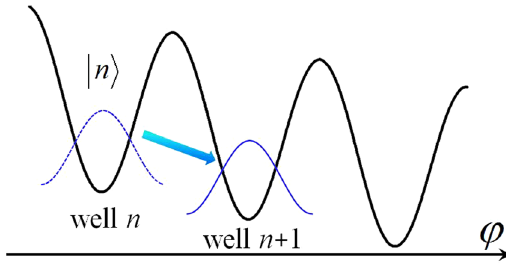
Figure 1. Schematic diagram of phase particle tunneling. Quantum mechanical description of a phase particle tunneling between neighboring valleys in the tilted washboard potential. The tunneling is the transition from a Wannier state n to the neighboring state + n 1